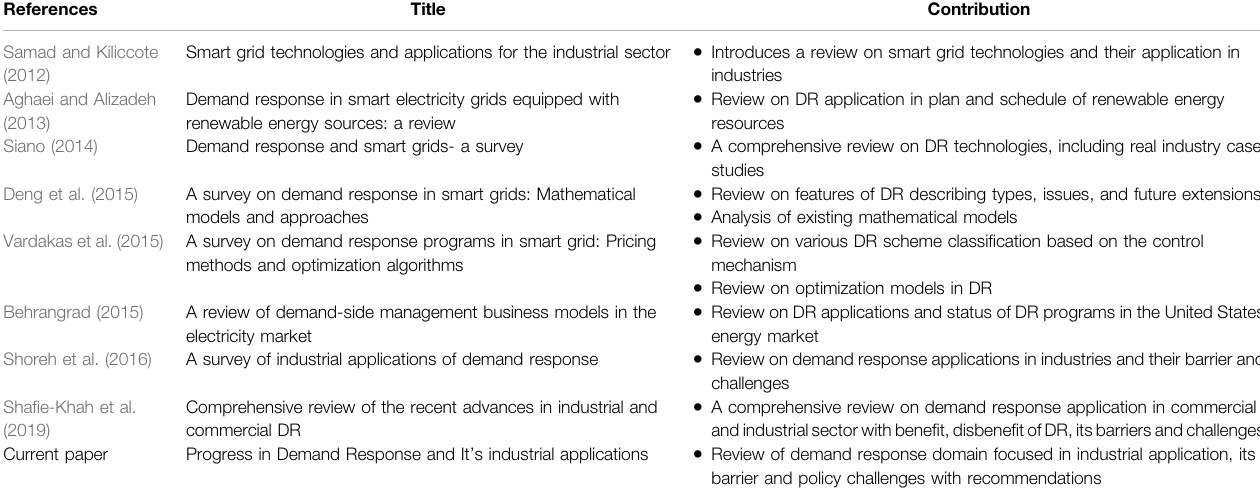
TABLE 1 | An overview of review papers in the fi eld of